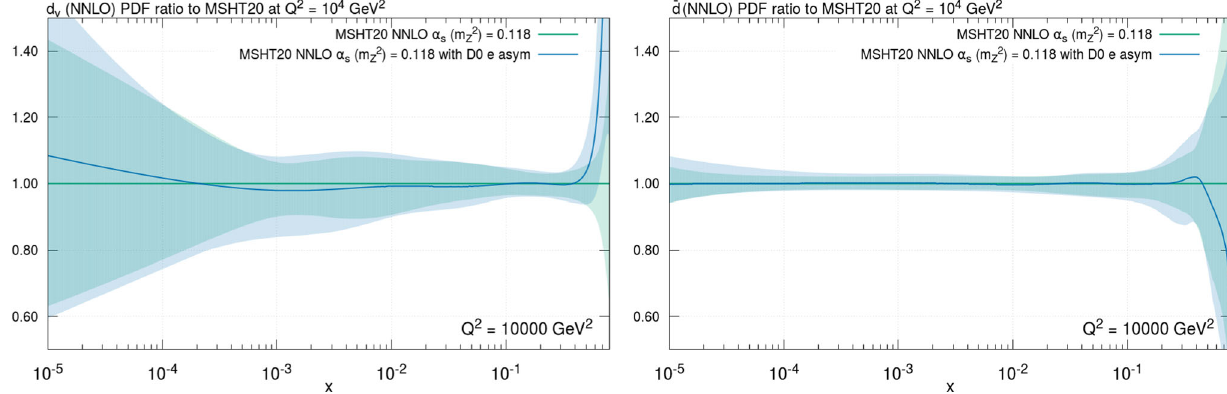
updated full NNLO theory (VFNS) is shown. The two plots show the result of the global fit excluding (left) and including (right) the ATLAS 7 and 8 TeV precision W , Z data